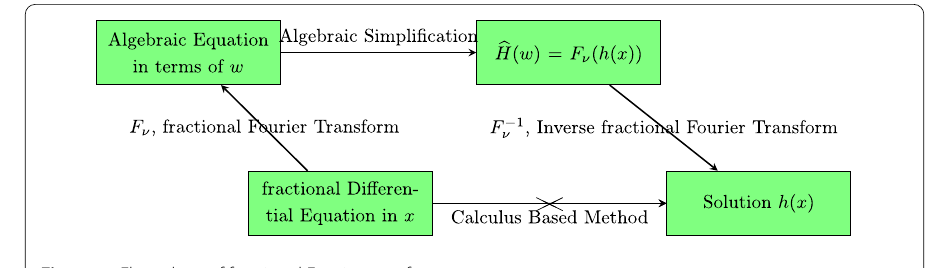
Figure 1 Flow chart of fractional Fourier